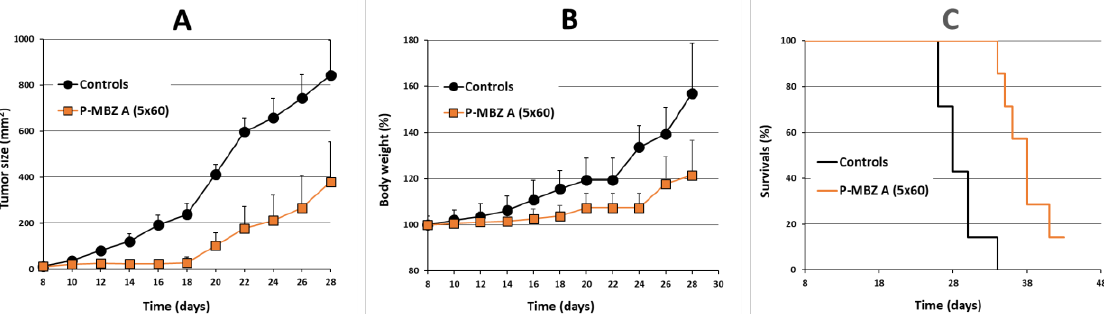
Figure 6. Antitumour activity of prolonged treatment with polymer-bound mebendazole conjugate in vivo. B6 mice ( n = 7) were s.c. inoculated with 10 5 EL-4 cells on day 0, then i.p. injected with 5 doses (60 mg mebendazole/kg per one dose) of HPMA copolymer-bound mebendazole conjugate ( P-MBZ-A (5 × 60)) on days 8, 10, 12, 14, and 16. Untreated mice were used as controls. Tumour growth ( A ), body weight ( B ), and survival ( C ) were monitored, and each experimental point ( A , B ) is the average of the experimental group ± SD.